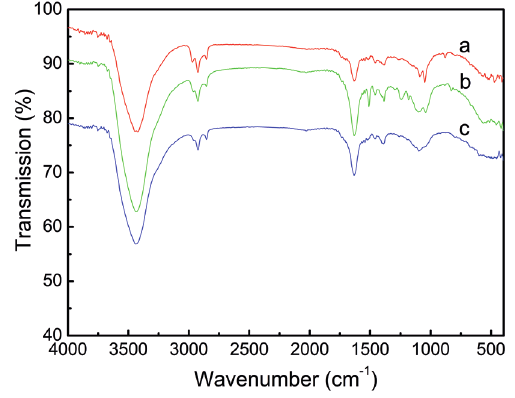
Figure 3: FTIR spectra of the ferrosilicon particles: (a) unmodified, (b) modified–coated, and (c)